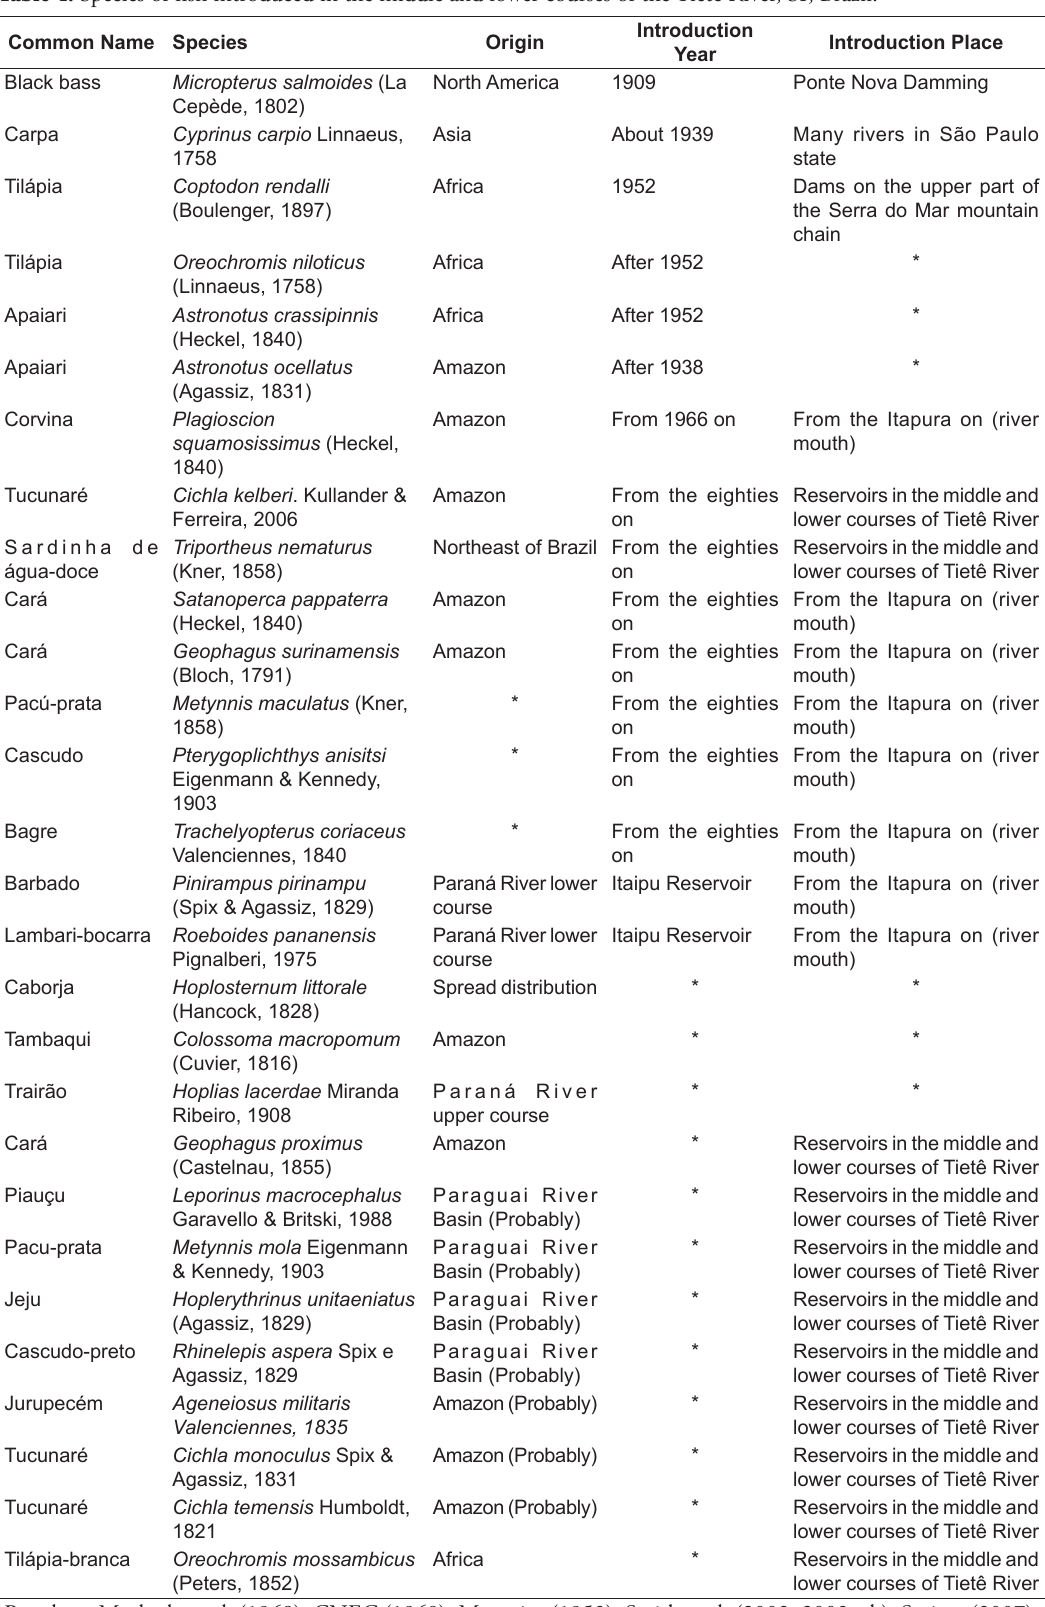
Table 4. Species of fish introduced in the middle and lower courses of the Tietê River, SP, Brazil. Common Name